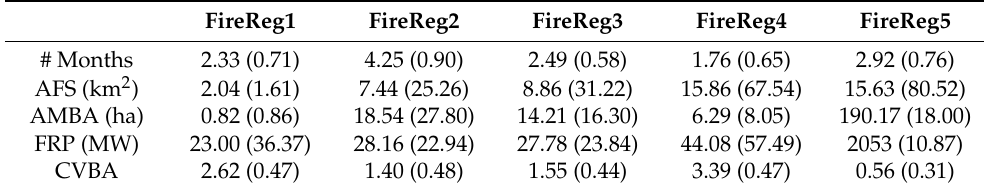
Table A3. Mean value of each attribute for each identified fire regime selecting five clusters. The standard deviation of the variables is shown in brackets. Correspondence among classes using 4 and 5 clusters: FireReg1 (FireReg2); FireReg2 (FireReg3); FireReg3 (FireReg2); FireReg4 (FireReg1); FireReg5